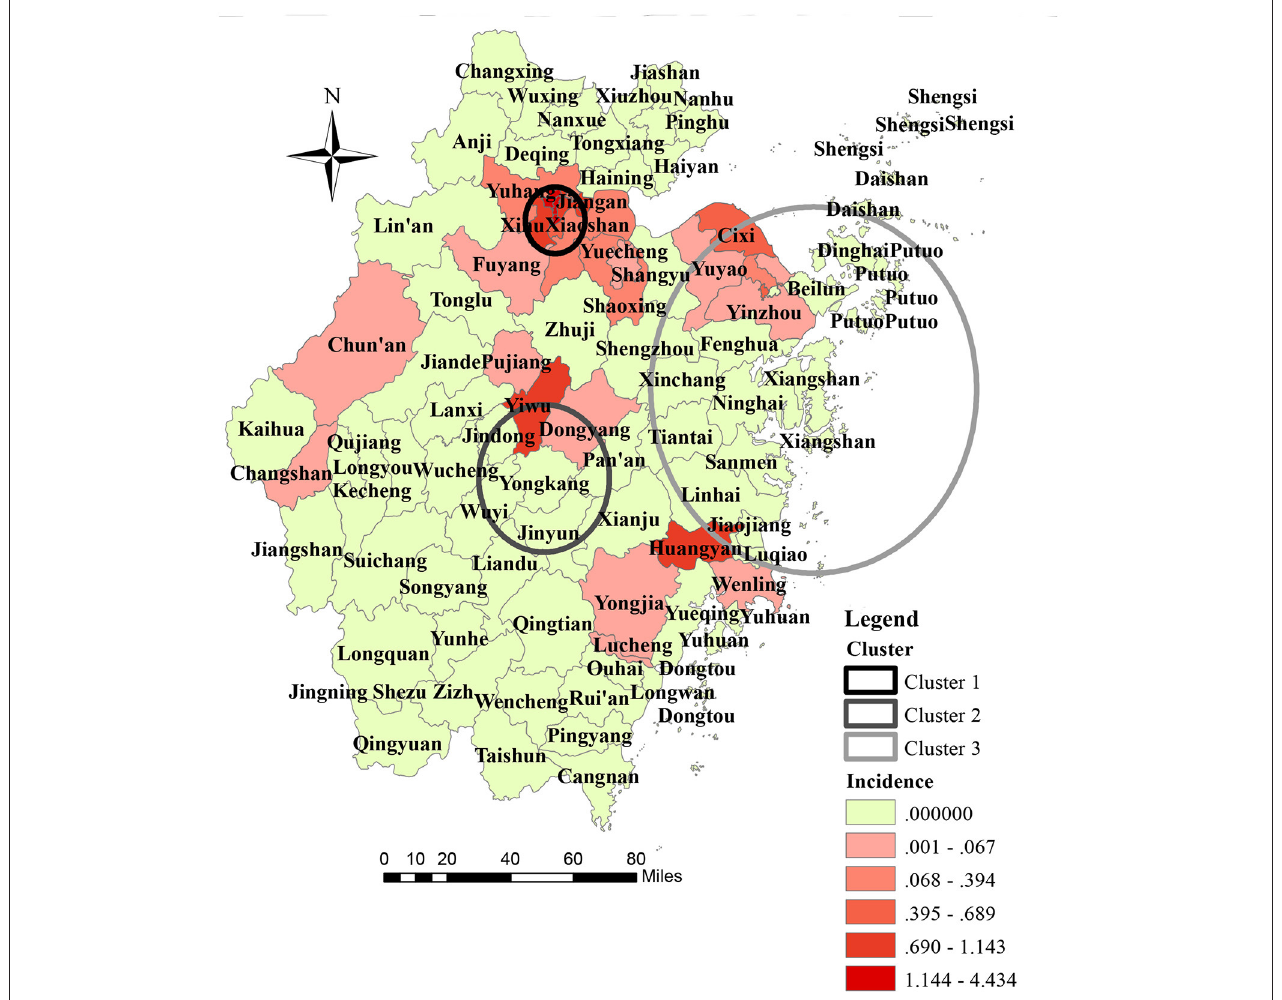
FIGURE 2 | Geographic distribution and space-time cluster of indigenous dengue case in Zhejiang Province from 2004 to